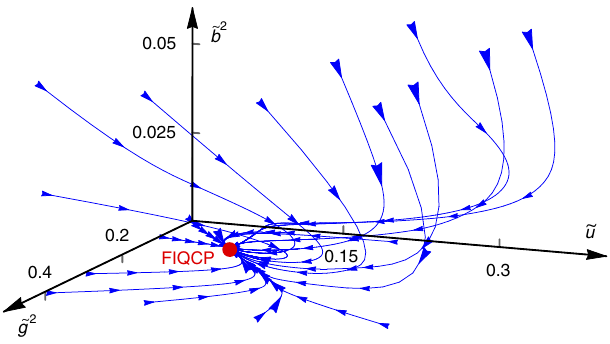
Fig. 2 The renormalization group fl ow of coupling constants. From The only stable fi xed point in the critical surface r = r c is denoted by the red point, which is the Gross – Neveu – Yukawa fi xed point representing an